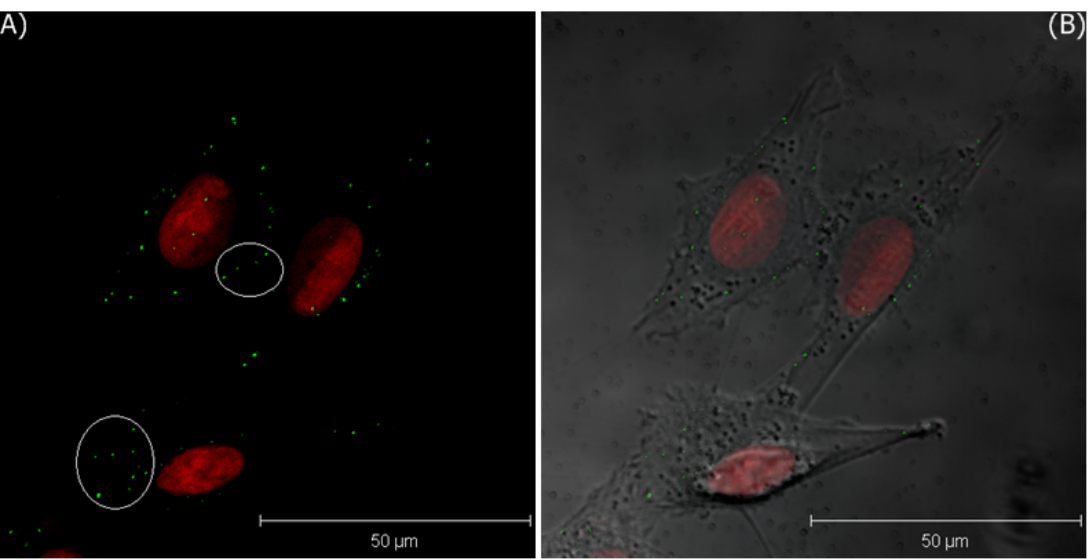
Figure 7. The 3D projection images of MDA-MB-435S cells incubated with bare GNPs in media after 30 minutes; A) LSCM image, and B) the merged image of LSCM and the phase contrast images, where the green lightspots are the expression of